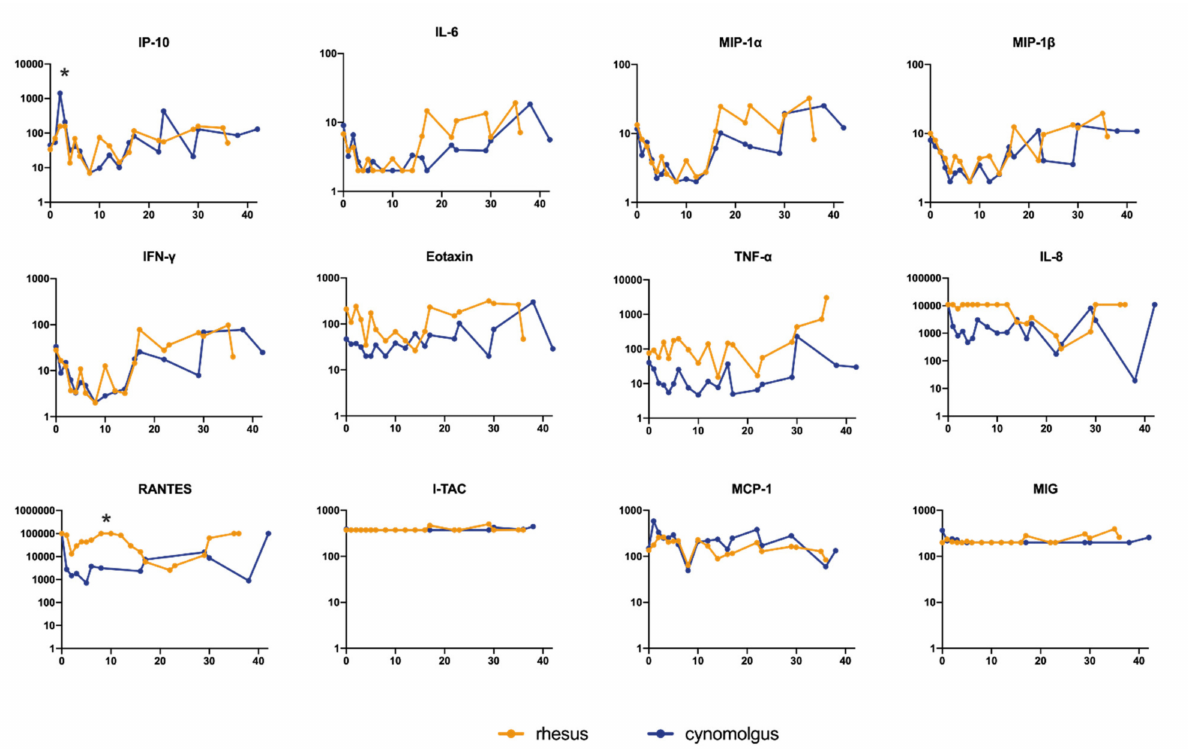
Figure 4. Cytokine and chemokine levels in peripheral blood after SARS-CoV-2 infection. Longitudinal sera collected after SARS-CoV-2 infection were tested. Results were expressed as pg/mL. Statistically significant differences in the geometric mean between rhesus and cynomolgus macaques are indicated with